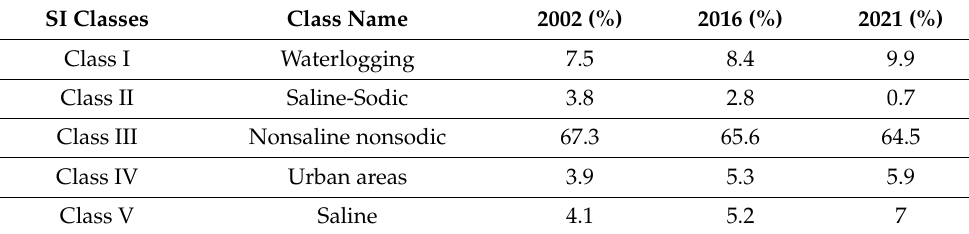
Table 8. Output classes from the proposed